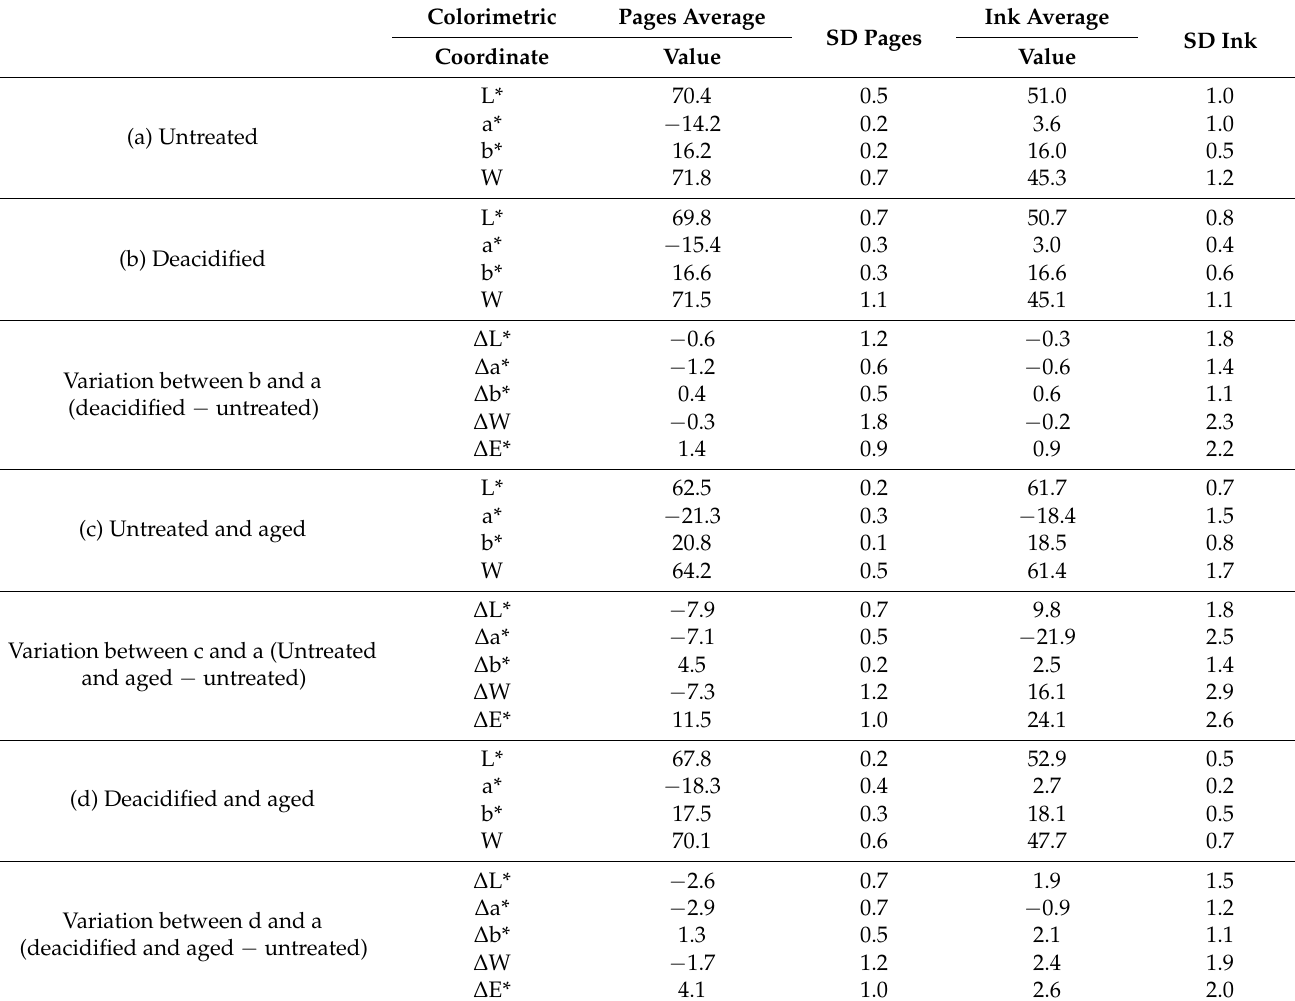
Table 3. Colorimetric coordinates before and after deacidification treatment and before and after aging.